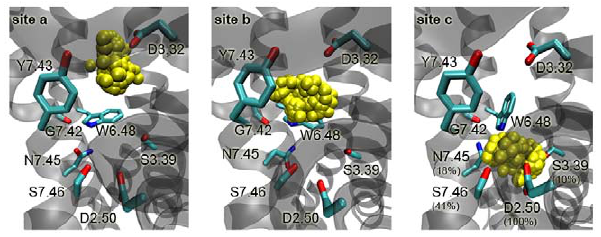
Figure 2. Sodium ion binding between the orthosteric and allosteric site. Distribution of sodium ions (yellow spheres) for binding sites a ( z , 2 5.0 A˚, orthosteric), b ( z , 2 7.5 A˚) and c ( z , 2 15.0 A˚, allosteric) between Asp3.32 and Asp2.50. In site c , the percentage of